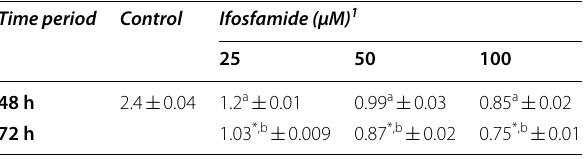
Data represent mean SE, n 3 ± = 1 Ifosfamide was used in its IC 50 value beside two of its fractions; 25 and 50 µM The number of HepG2 cells used was in the range of 5 10 5 ~ 5 10 6 cells/mL × × Bcl2 content was normalized to the reference β-actin gene and expressed as percent expression relative to untreated control cells * Significantly different from the same concentration incubated with HepG2 cells for 48 h at P < 0.05, using independent Student’s t test a,b Data in the same rows having the same superscript are significantly different from each other at P < 0.05 using one-way analysis of variance (ANOVA) followed